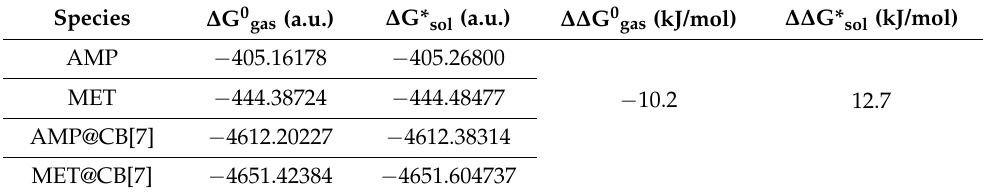
Table 3. Thermodynamic parameters used for the computation of standard free energy change.